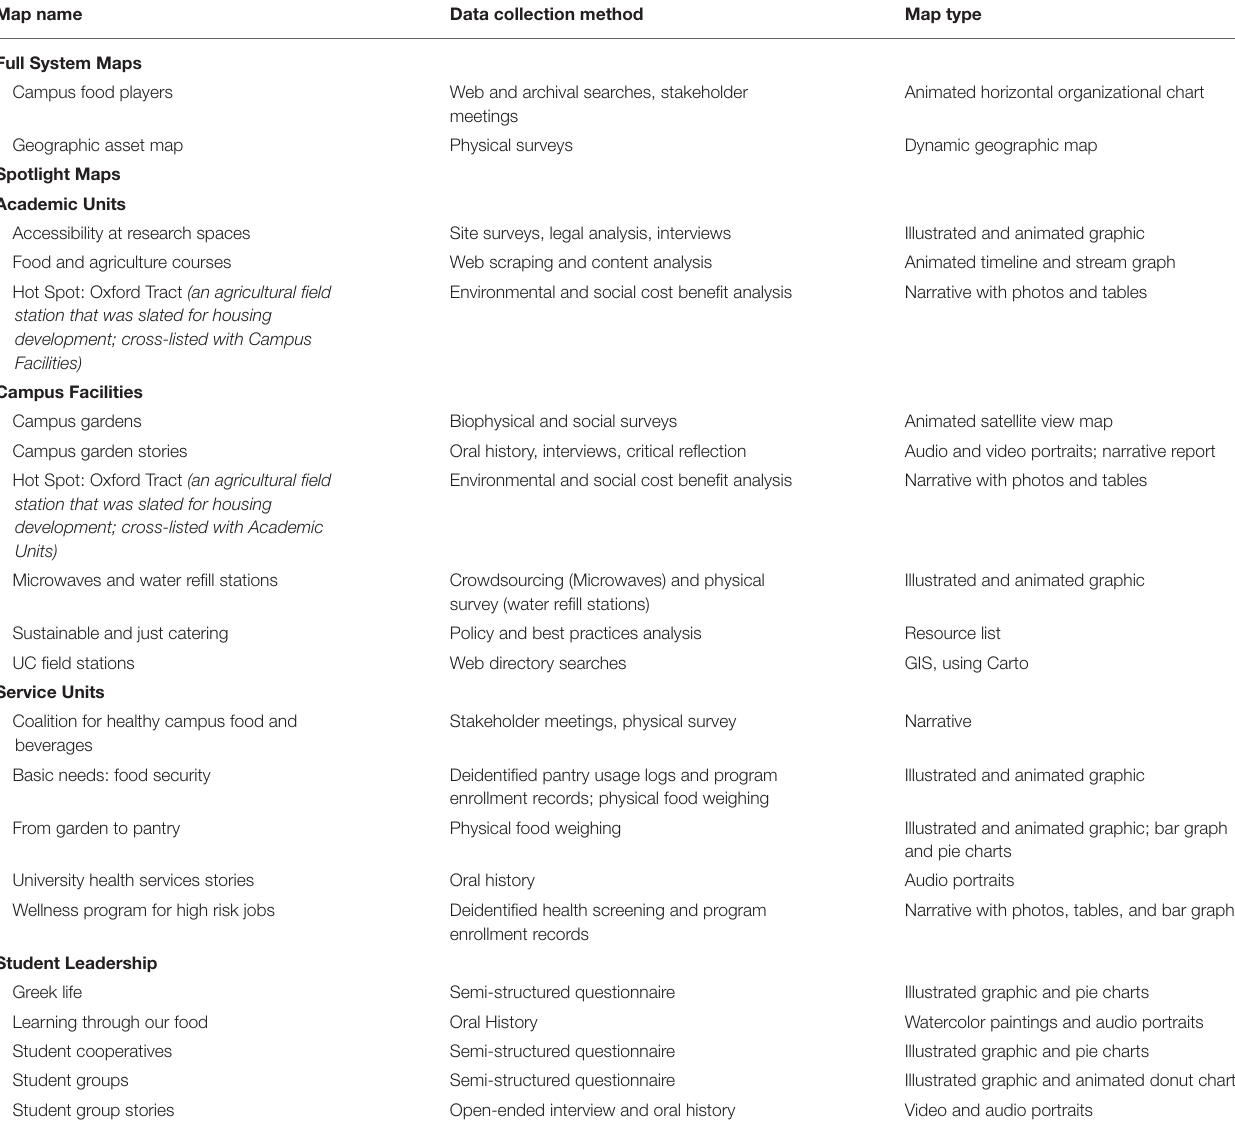
TABLE 1 | Foodscape mapping project full system maps and spotlight